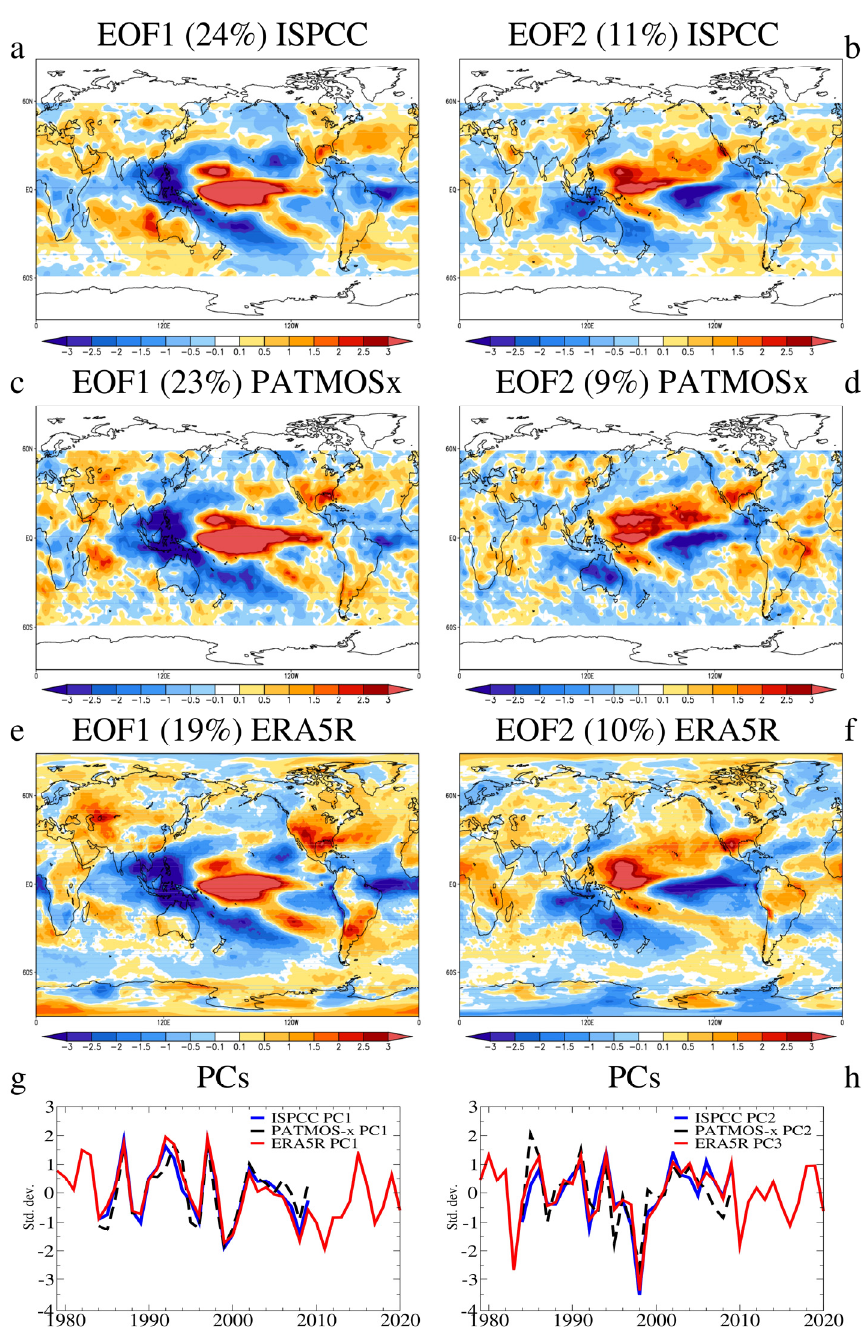
Figure 1. Global modes of TCC variability in detrended satellite and ERA5 reanalysis data. Left column: The spatial structure of the dominant mode (EOF1) of TCC variability (%) based on ISCCP ( a ), PATMOS-x ( c ) and ERA5 reanalysis ( e ) data with their associated time series ( g ). Right column: The second empirical orthogonal function (EOF2) of TCC variability (%) based on ISCCP ( b ) and PATMOS-x ( d ) data and the third EOF from ERA5 reanalysis ( f ) data, with their associated time series ( h